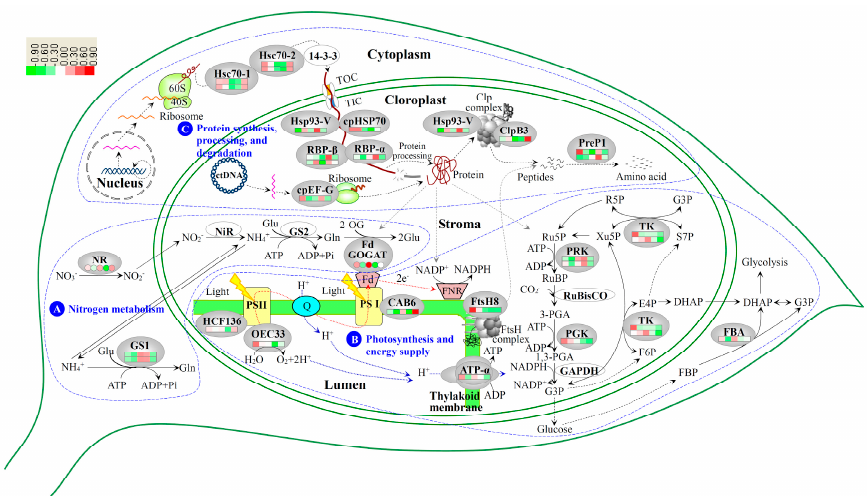
Figure 9. Schematic presentation of the leaf color regulation mechanism in chimera Hosta “Gold Standard” leaves. The identified proteins were integrated into subcellular pathways. A, Nitrogen metabolism; B, Photosynthesis and energy supply; C, Protein synthesis, processing and degradation. Protein expression patterns and enzyme activities are marked in the oval shapes with squares and circles in different colors, respectively. The increased and decreased proteins are represented in red and green, respectively. The color intensity increases with increasing abundant differences. The solid line indicates single-step reaction, and the dashed line indicates multistep reaction. Abbreviation: 2-OG, 2-oxoglutarate; 40S, eukaryotic small ribosomal subunit; 60S, eukaryotic large ribosomal subunit; ATP- α , ATP synthase alpha chain; CAB6, chlorophyll a/b binding protein 6; ClpB3, chloroplastic chaperone protein ClpB3; cpEF-G, chloroplastic elongation factor G; cpHsp70, stromal 70 kDa heat shock-related protein; DHAP, dihydroxyacetone phosphate; E4P, erythrose-4-phosphate; F6P, fructose 6-phosphate; FBA, fructose-1,6- bisphosphate aldolase; FBP, fructose 1,6-bisphosphate; Fd, ferredoxin; FNR, ferredoxin-NADP reductase; FtsH8, ATP-dependent zinc metalloprotease FtsH8; G3P, glycerate 3-phosphate; GAPDH, Glyceraldehyde-3-phosphate dehydrogenase; Gln, glutamine; Glu, glutamate; GS1, cytosol-localized glutamine synthetase isoform; GS2, plastid-localized glutamine synthetase isoform; HCF136, photosystem II stability/assembly factor HCF136; Hsc70, heat shock congnate 70 kDa protein; Hsp93-V, heat shock protein 93-V(ClpC1, ClpA subunit); NiR, nitrite reductase; NR, nitrate reductase; OEC33, O 2 evolving complex 33kD family protein; PGA, 3-phosphoglyceric acid; PGK, phosphoglycerate kinase; PreP1, presequence protease 1; PRK, phosphoribulokinase; PSI, photosystem I; PSII, photosystem II; Q, quinine; R5P, ribose-5-phosphate; RBP, RuBisCO large subunit-binding protein subunit; Ru5P, ribulose-5-phosphate; RuBisCO, ribulose-1,5-bisphosphate carboxylase; RuBP, ribulose-1,5-bisphosphate; S7P, sedoheptulose-7-phosphate; TIC, translocon at the inner envelope membrane of chloroplasts; TK, transketolase; TOC, translocon at the outer envelope membrane of chloroplasts; Xu5P, xylulose-5-phosphate.